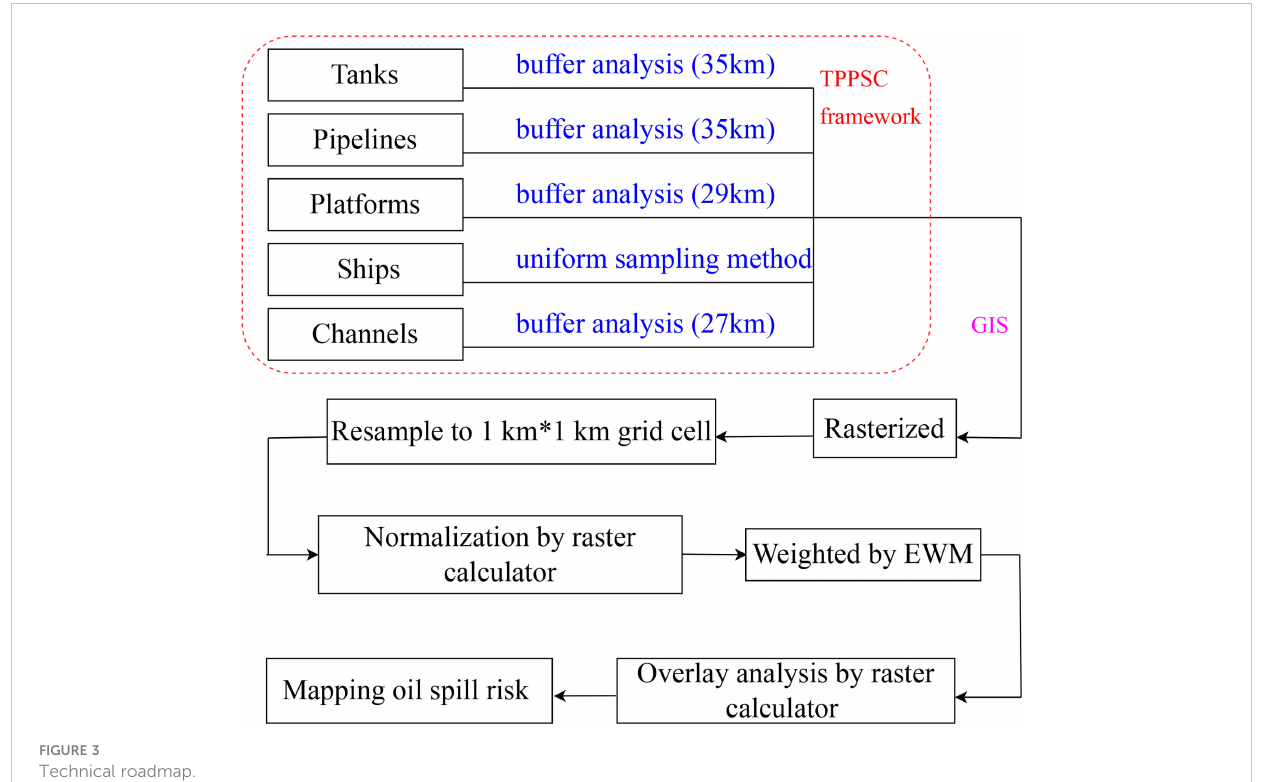
FIGURE 3 Technical